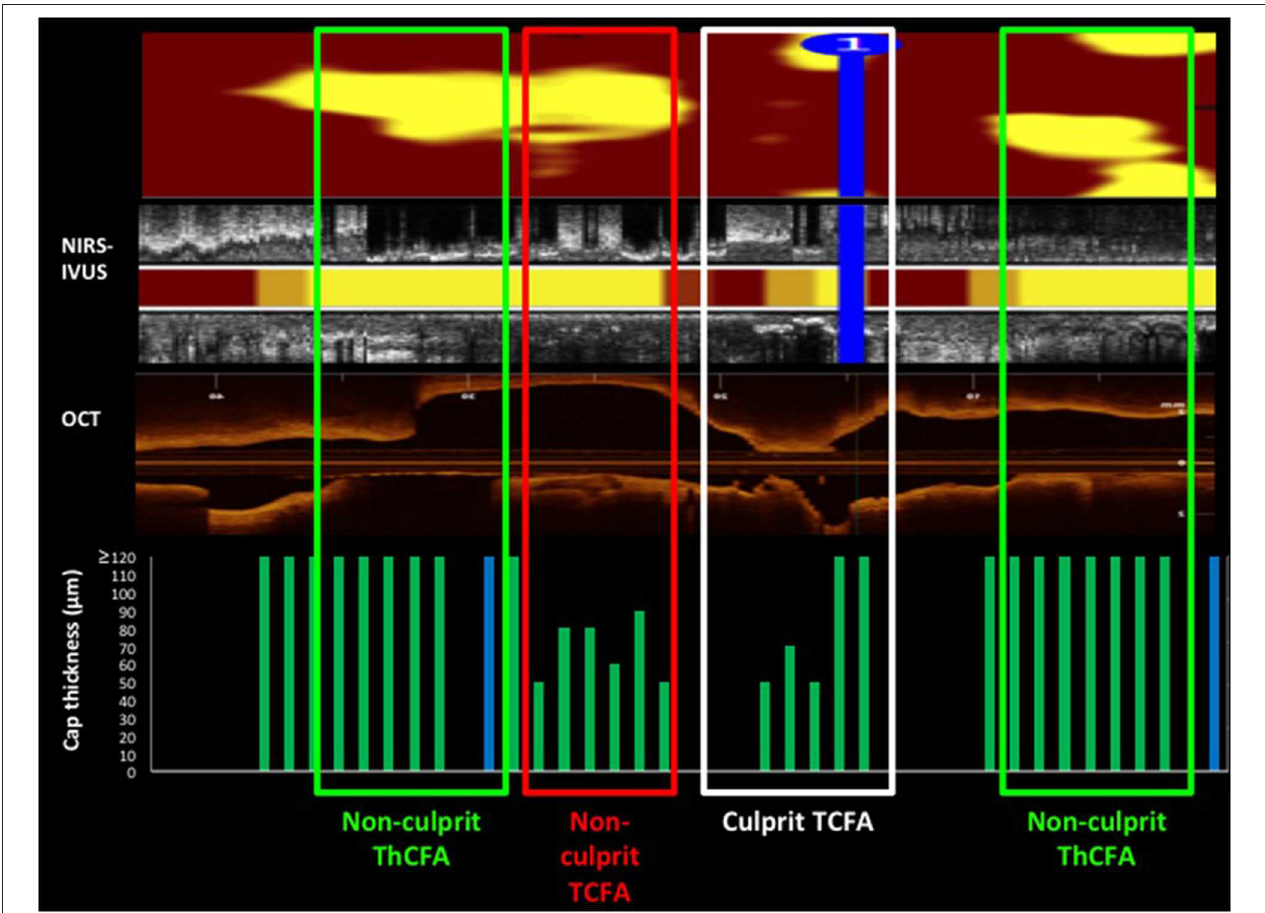
FIGURE 6 | A comparison of NIRS-IVUS and OCT imaging data in a patient with a coronary event. OCT was used to measure cap thickness in regions with lipid detected by NIRS and was able to differentiate lipid cores with thick and thin caps. The culprit lesion, identified by angiography plus IVUS and OCT imaging is indicated on the NIRS-IVUS and OCT pullbacks. The culprit lesion occurred at the relatively small lipid core plaque that had a thin cap as determined by OCT. The NIRS chemogram shows 2 large lipid core plaques (yellow spots) at non-culprit sites. Personal Communication from Dr. Ryan Madder.